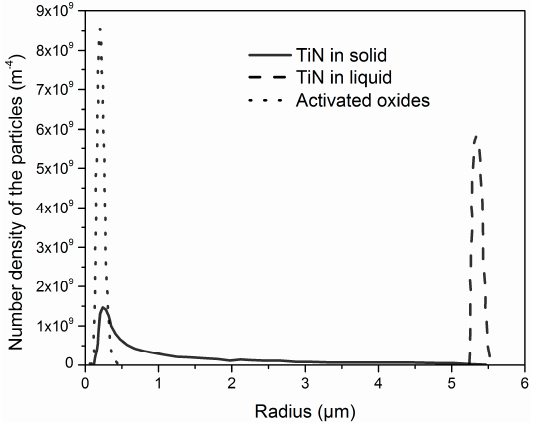
Figure 14. Initial oxide distribution in the liquid and TiN distributions in the liquid and solid phases at the final stage of solidification [126].